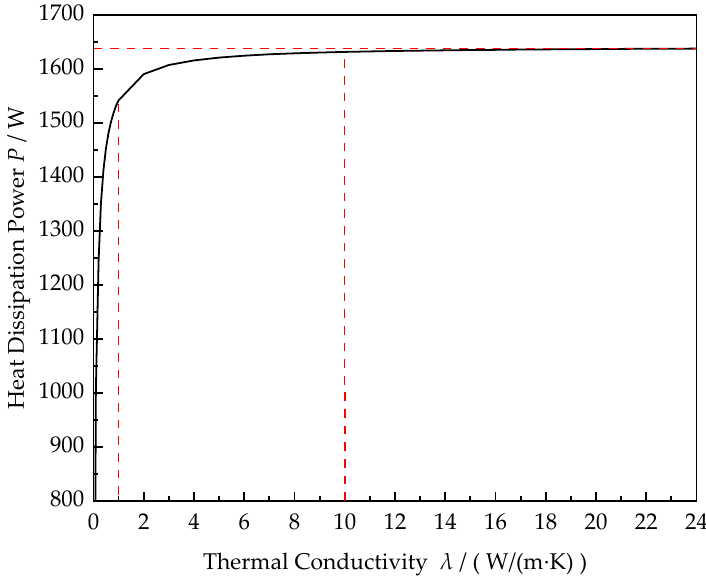
Figure 7. Curve of heat dissipation power of tank with thermal conductivity.